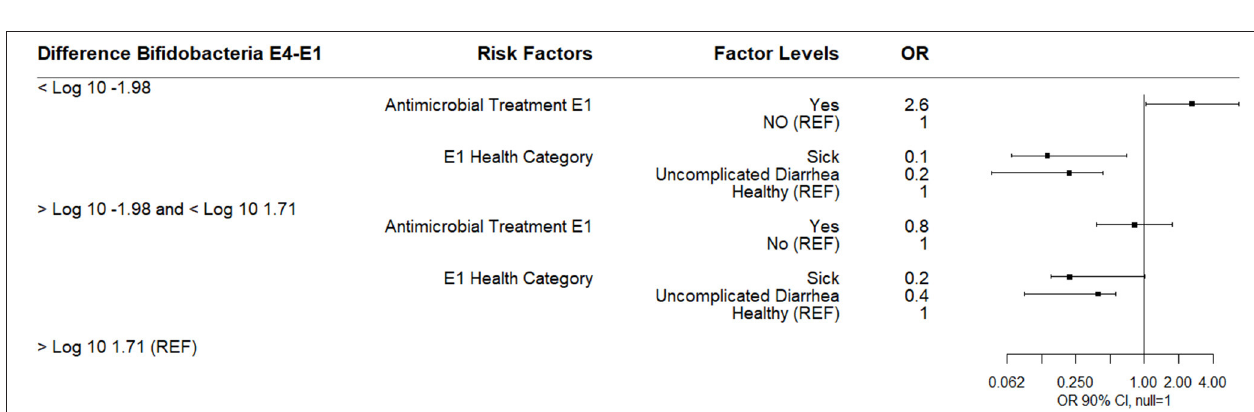
FIGURE 3 | Results of multinomial logistic regression modeling the change in Log 10 Bifidobacterium copies/gram fecal between sampling day E4 and sampling day E1 (enrollment). Odds ratios and 90% confidence intervals are shown. E1 antimicrobial categories were defined as: yes (received 3-day course of intramuscular ampicillin) or no (did not receive an antimicrobial). E1 health categories were defined as: sick (diarrhea with not finishing milk meal or depressed attitude), uncomplicated diarrhea (diarrhea with no additional clinical signs), and